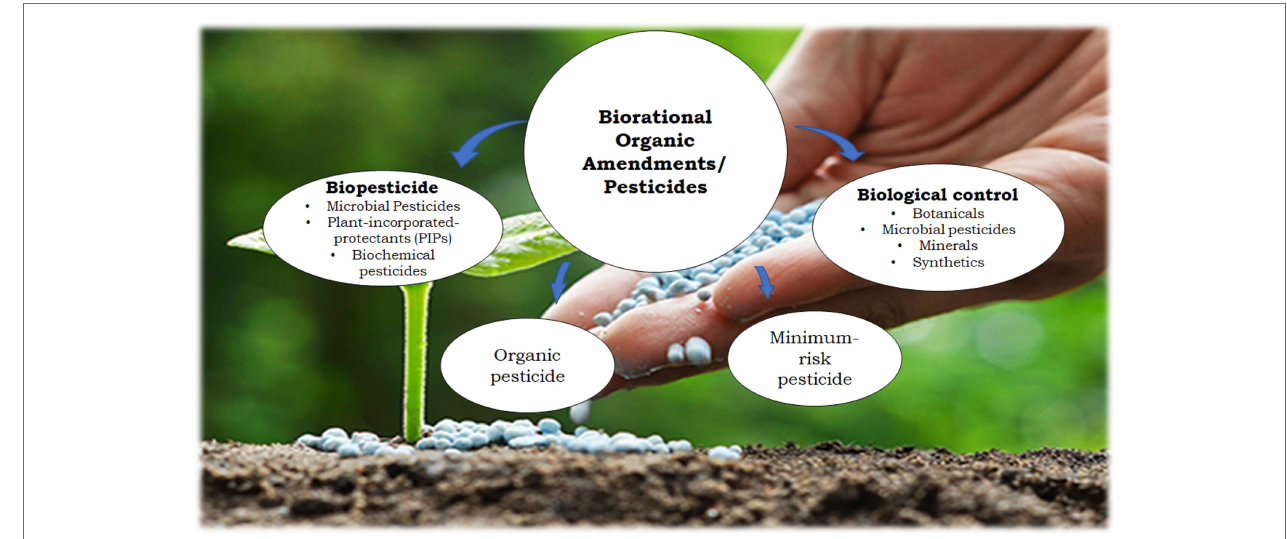
FIGURE 1 | Biorational use of organic amendments in